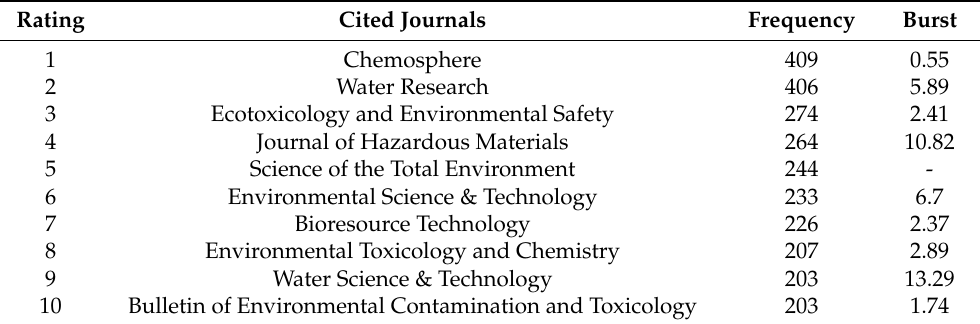
Figure 10. The results were achieved to analyze the most cited journals contributing to the field of industrial effluent and sludge toxicity from 1951 to 2020(the visualization of the cited journals ( a ) and the visualization of clustering of the cited journals ( b )). Table 6. The top 10 highly cited journals in the field of industrial effluent and sludge toxicity from 1951 to 2020. Some of the mentioned journals do not possess a corresponding burst amount since they did not receive a high number of citations over a short period of time (represented with “-”).